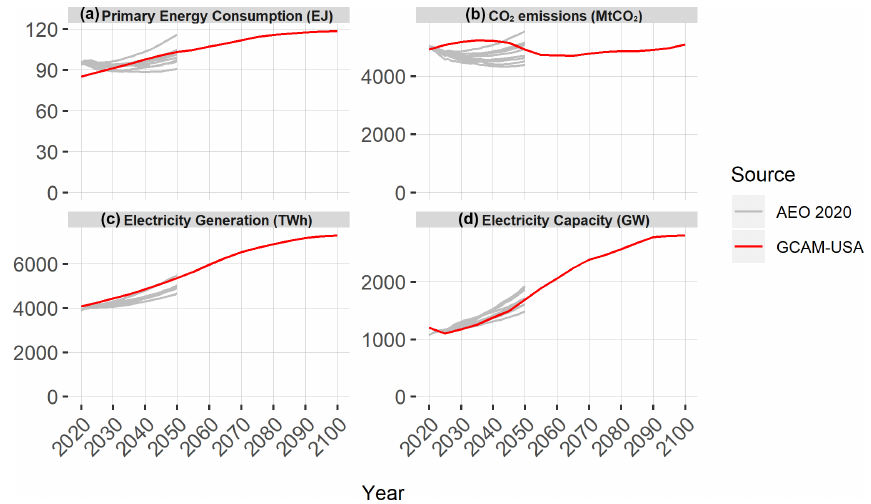
Figure 13. Comparison of national energy system projections from GCAM-USA (red line) and nine scenarios from the EIA’s 2020 Annual Energy Outlook (grey lines). Results for (a) primary energy consumption, (b) energy system CO 2 emissions, (c) electricity generation, and (d) electricity